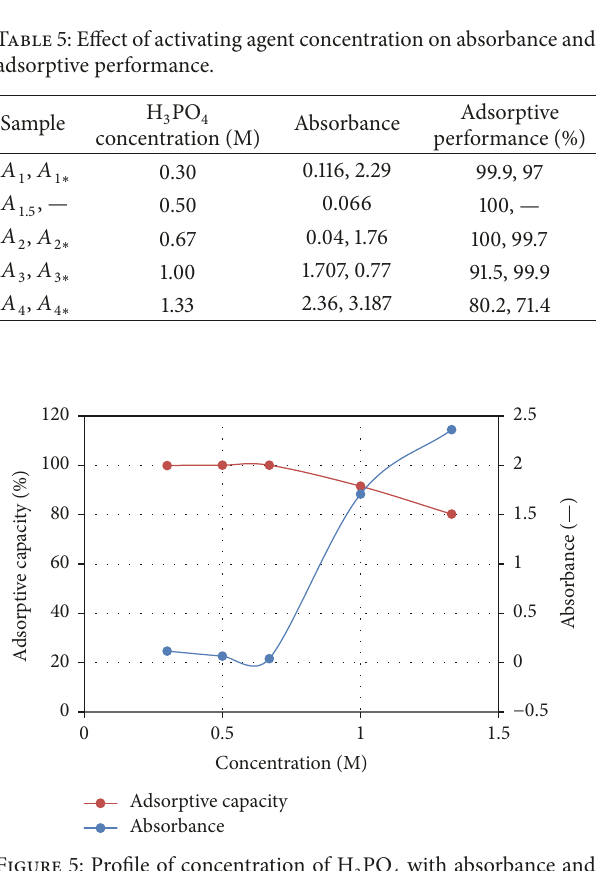
Figure 5: Profile of concentration of H 3 PO 4 with absorbance and adsorptive performance samples.